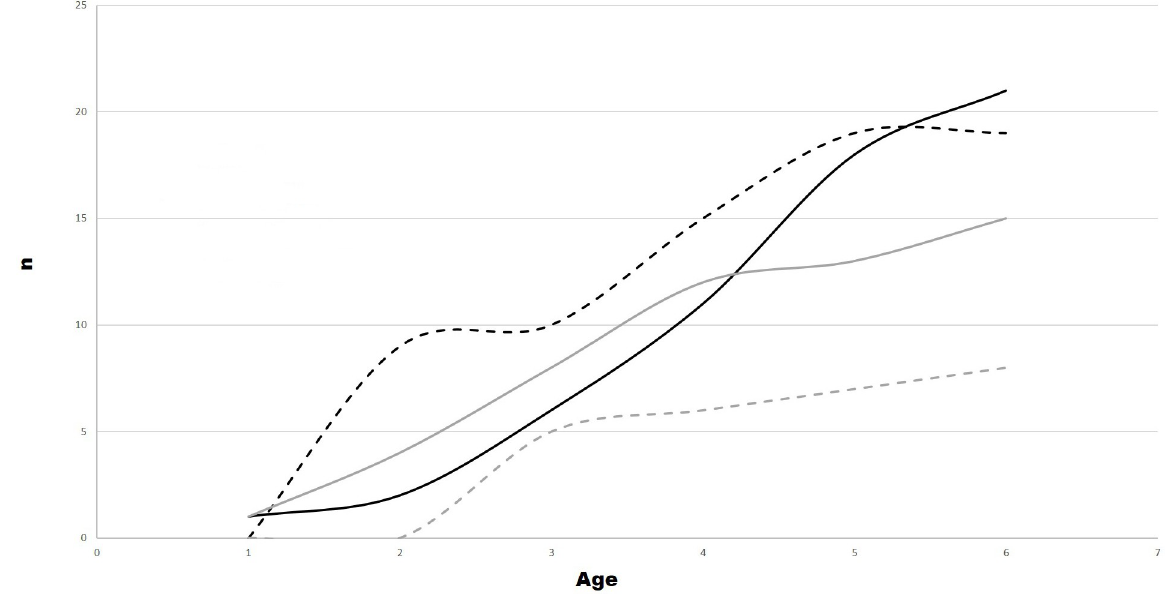
Fig 3. Cumulative counts of orthopedic injury cases by age and gonadectomy category. The solid black line is intact dogs, the dashed black line shows dogs gonadectomized � 6 months, the solid gray line shows dogs gonadectomized 6 months– 1 year, and the dashed gray line show dogs gonadectomized > 1 year of age.